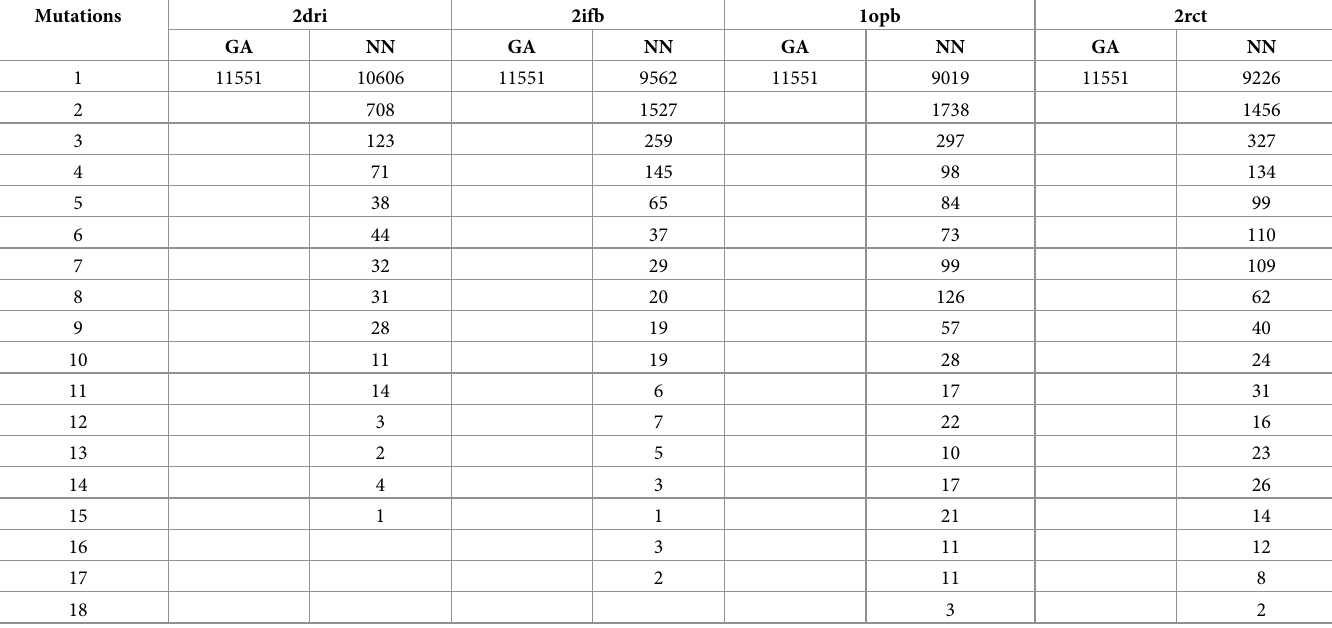
The table lists numbers of candidate sequences cand GA OPT r = 100 . For this analysis, r = 100 iterations of the designs for the four proteins from repr_prot were